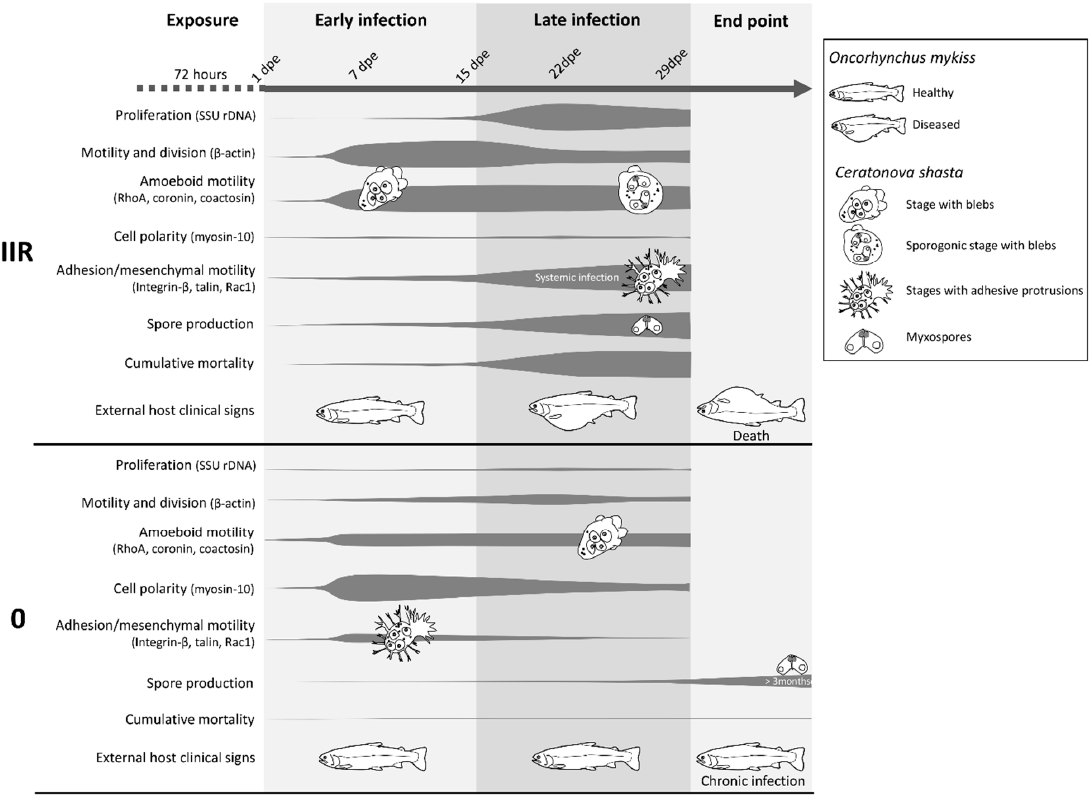
Figure 8. Model summarizing the infection dynamics, parasite motility and proliferation of Ceratonova shasta genotypes IIR and 0 in the intestine of rainbow trout, combining results from visual observations, parasite molecular quantification and gene expression, and host clinical